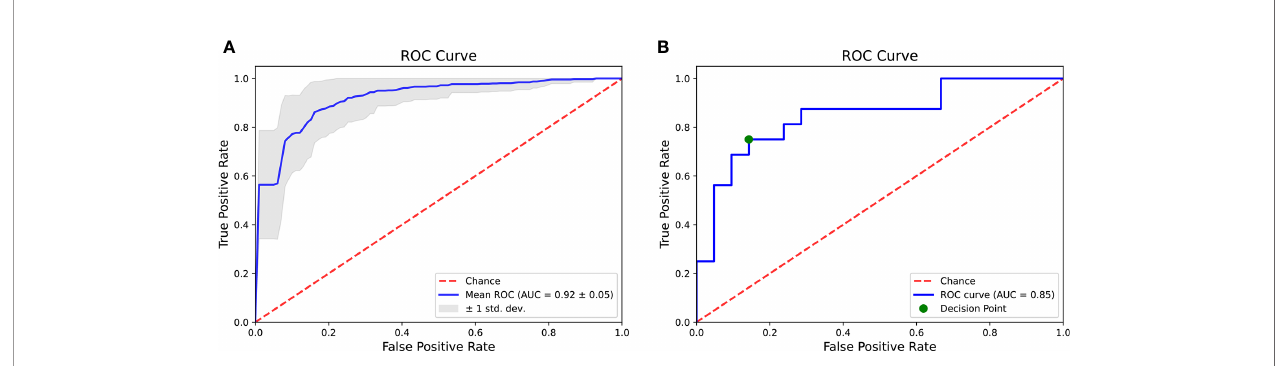
FIGURE 4 | Areas under the receiver operating characteristics curve of the radiomic classi fi er after ten-repeated 5-fold cross-validation (A) and on the test set (B) .